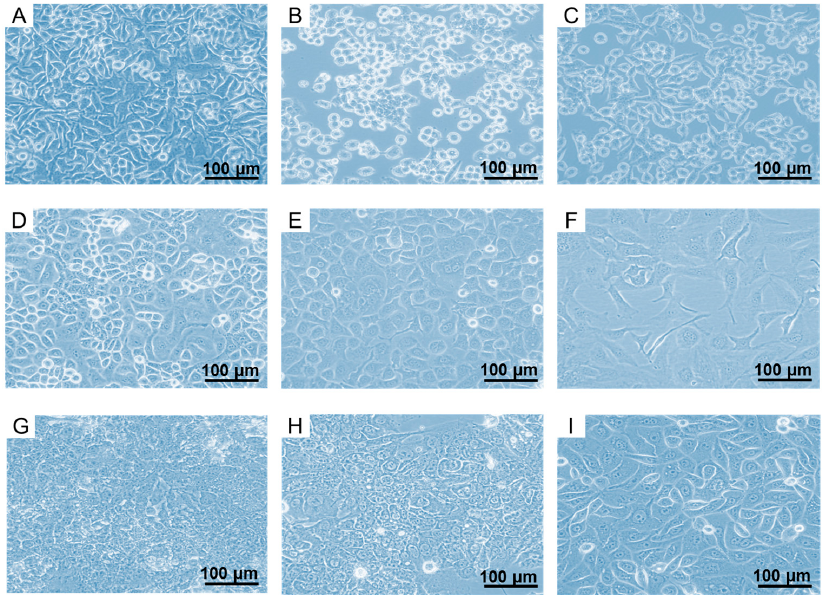
Figure 1. Microscopic images of ( A ) HeLa cells; ( B ) KB cells and ( C ) KB-V1 cells; ( D ) IGROV-1 cells; ( E ) SKOV-3 cells and ( F ) SKOV-3.ip cells; ( G ) JAR cells; ( H ) BeWo cells and ( I ) EFE-184